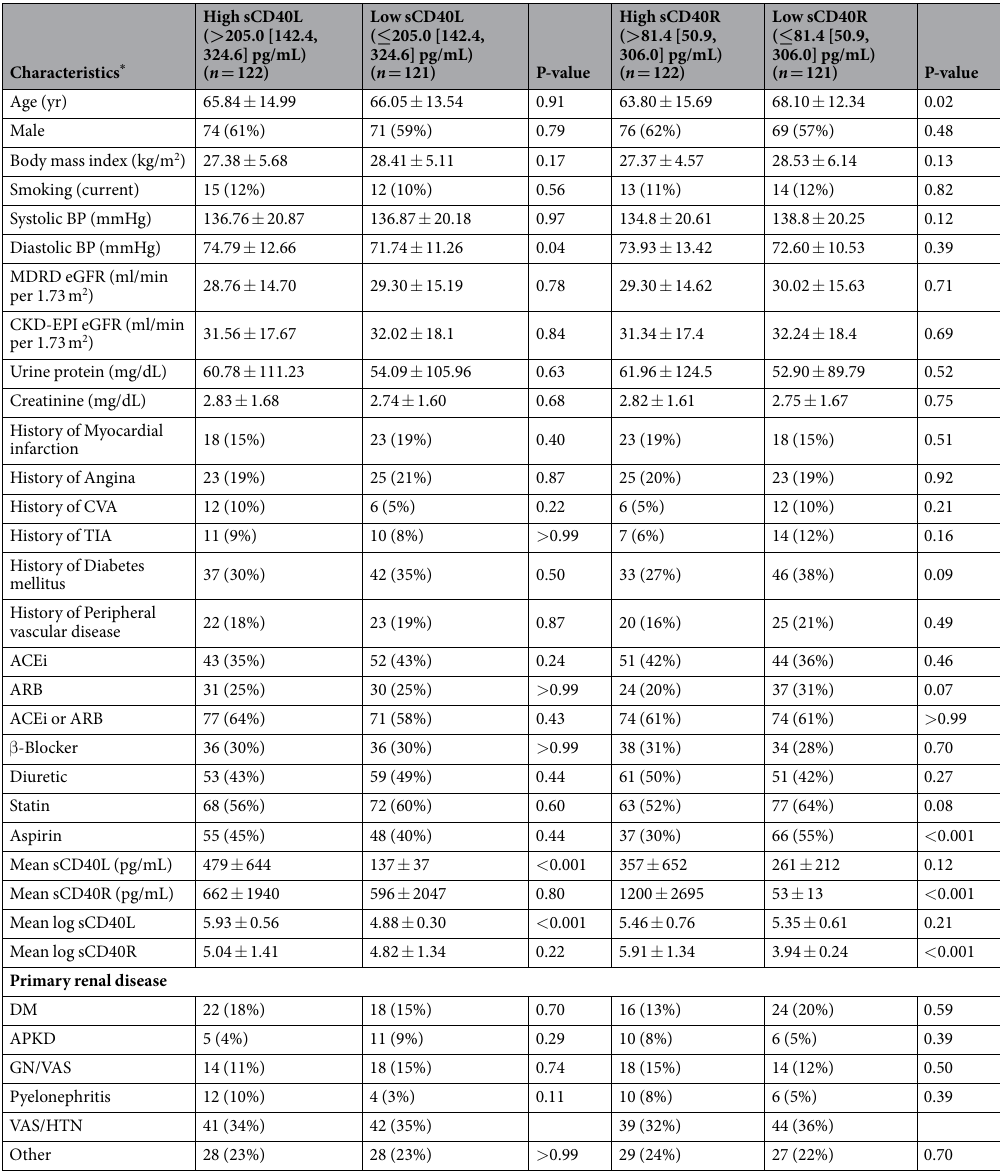
Table 1. Baseline Clinical Characteristics among Participants in the CRISIS Clinical Trial. Subjects are stratified by median plasma levels of sCD40L or sCD40R. * Data are expressed as the mean ± SD or number (percentage). Comparisons were evaluated using two sample t-test for continuous data and Fisher’s exact test for categorical data. Abbreviations : sCD40L, soluble CD40 ligand; sCD40R, soluble CD40 receptor; yr, year; m, meter; kg, kilogram; BP, blood pressure; MDRD, Modification of Diet in Renal Disease; CKD-EPI, Chronic Kidney Disease Epidemiology Collaboration; eGFR, estimated glomerular filtration rate; CVD, cerebral vascular accident; TIA, transient ischemic accident; ACEi, angiotensin converting enzyme inhibitor; ARB, angiotensin receptor blocker; and β -Blocker, beta adrenergic blocker DM, diabetic glomerularnephritis; APKD, adult polycystic kidney disease; GN/VAS, glomerularnephritis vasculitis; VAS/HTN, vascular